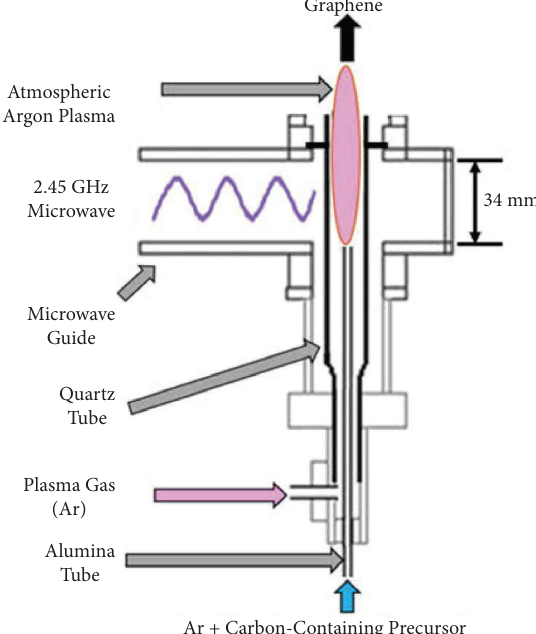
Figure 19: Microwave plasma reactor for GSG production